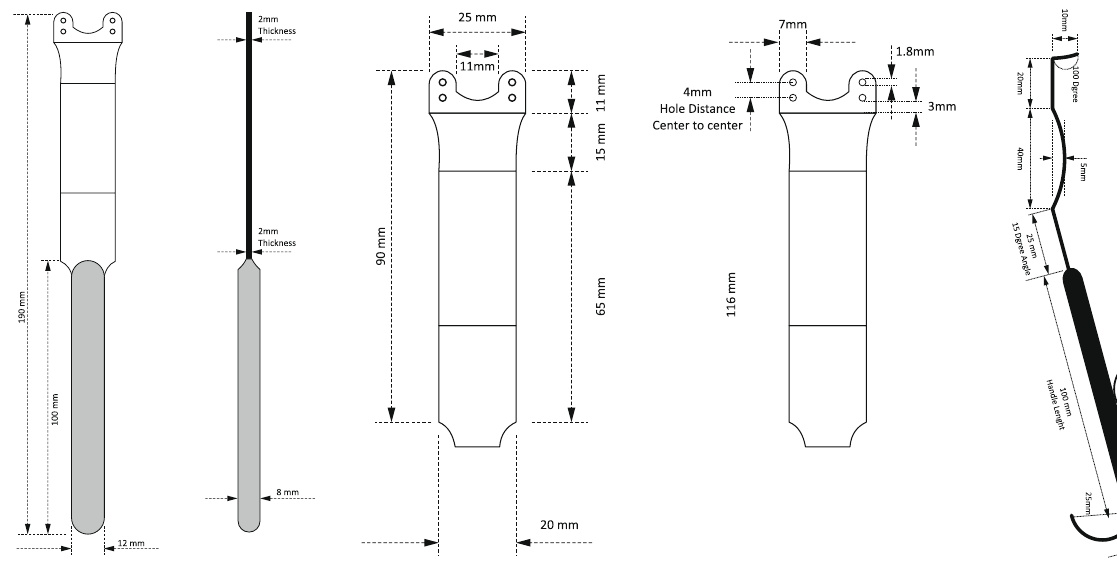
Fig. 1 Dimensions of the Persian chin holder and retractor